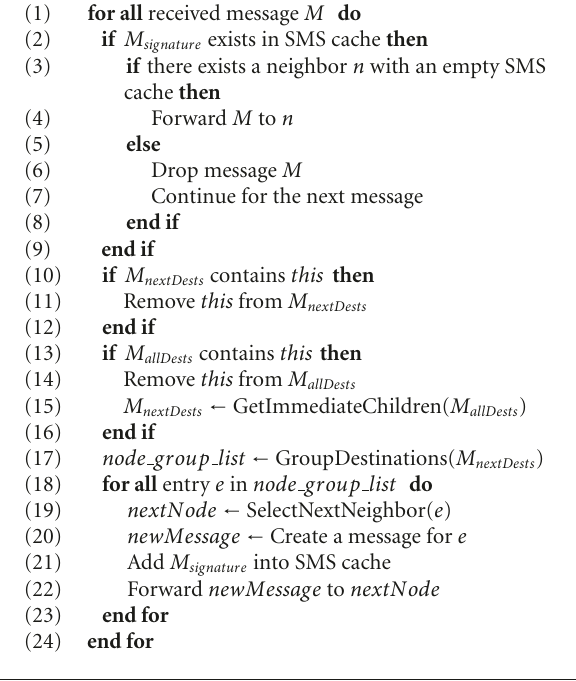
Algorithm 7: Location-Based Multicasting with Direction Accord- ing to MST.